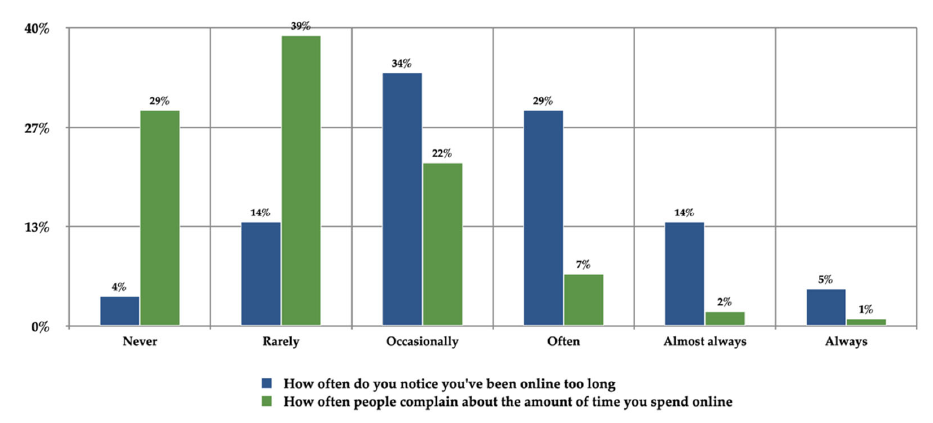
Figure 7. Perceptions and attitudes about time spent online.